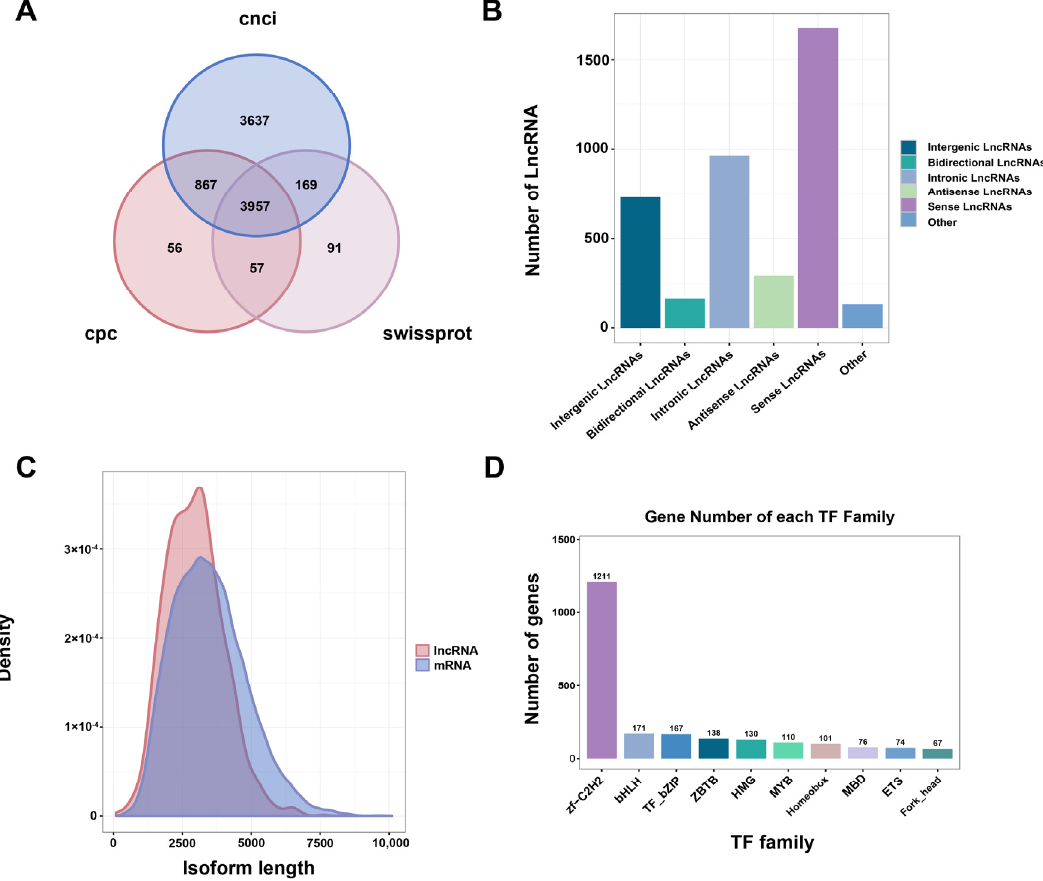
Figure 9. The identification of lncRNA and TFs based on the SMRT sequencing in H. armiger . ( A ) Venn diagram of lncRNA predicted by CNCI, CPC, and Swissprot tools. ( B ) Proportions of different types of lncRNAs. ( C ) Length distribution of identified lncRNAs and mRNA in H. armiger . ( D ) The number and family of TFs were predicted by SMRT.